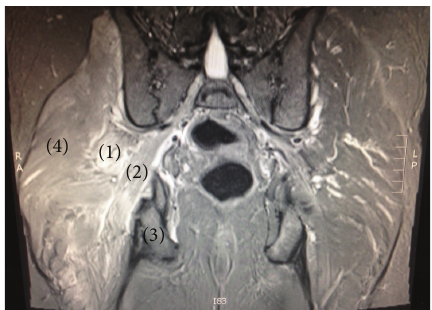
Figure 1: Signal abnormality of the right short external rotators on coronal section of T2-weighted MRI. (1) Piriformis. (2) Obturator internus. (3) Ischium. (4) Gluteus maximus.